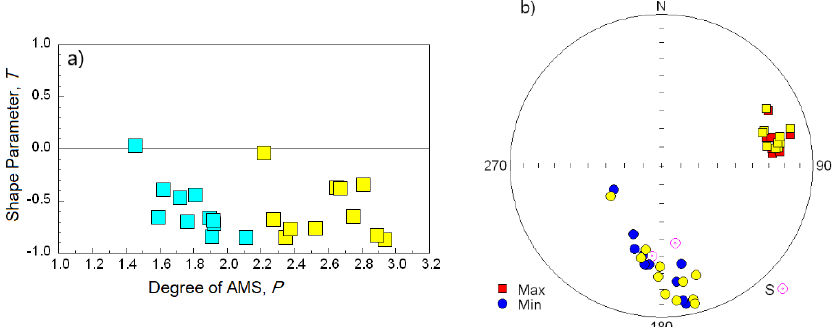
Figure 13. Magnetic anisotropy P - T plot ( a ) and orientations of magnetic foliation poles and magnetic lineations ( b ) in eclogite of the locality of Hutˇe. Yellow symbols denote the opAMS fabric, other symbols belong to ipAMS. In ( b ), equal-area projection on lower